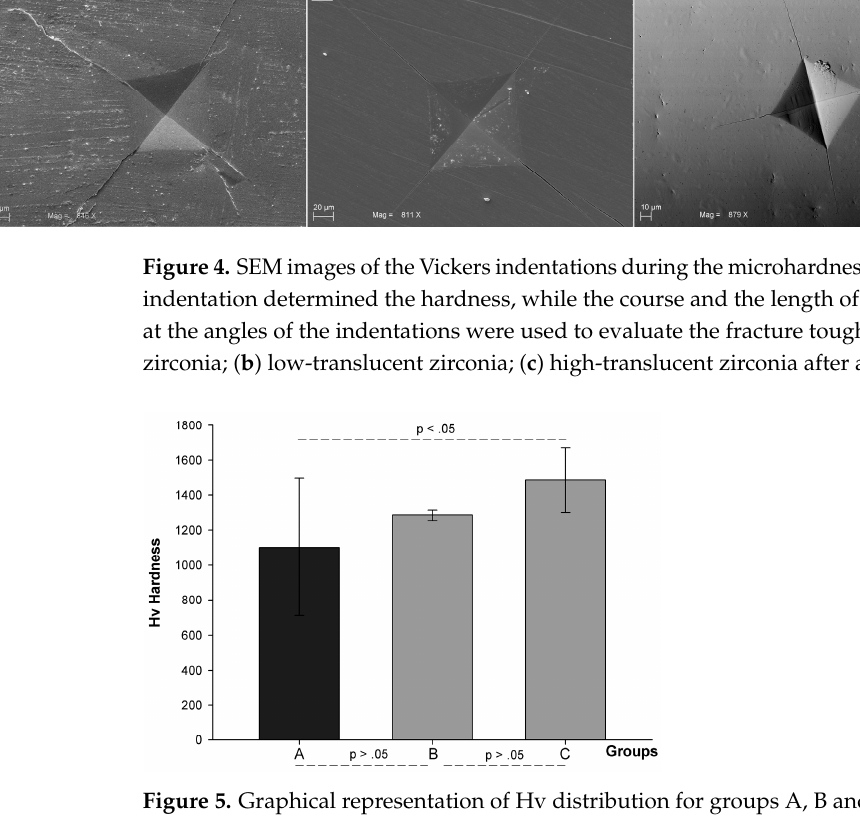
Figure 5. Graphical representation of Hv distribution for groups A, B and C.